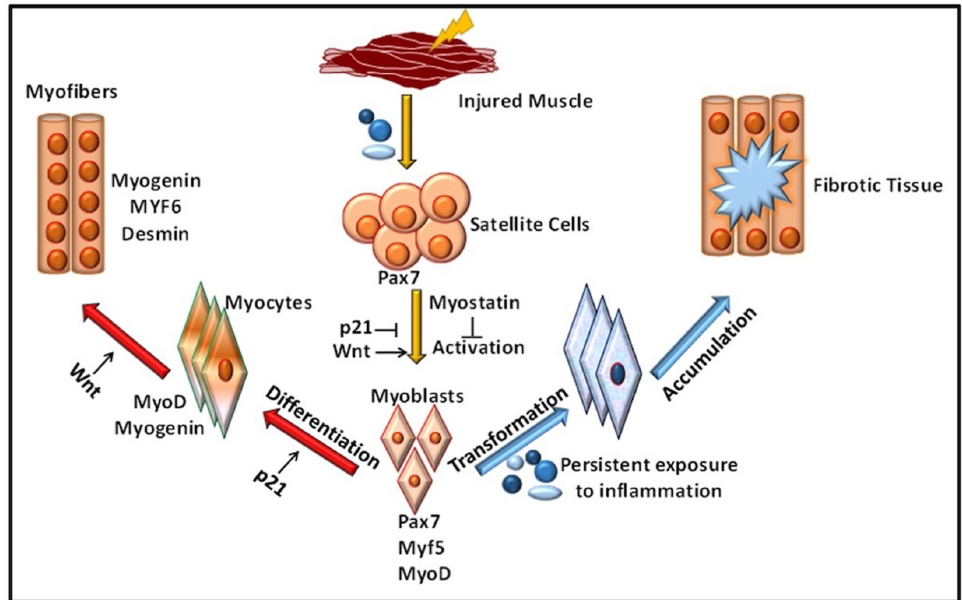
Figure 4. Cell transplantation in VML : As a result of the injury satellite cells are differentiated to generate muscle fibers in VML.